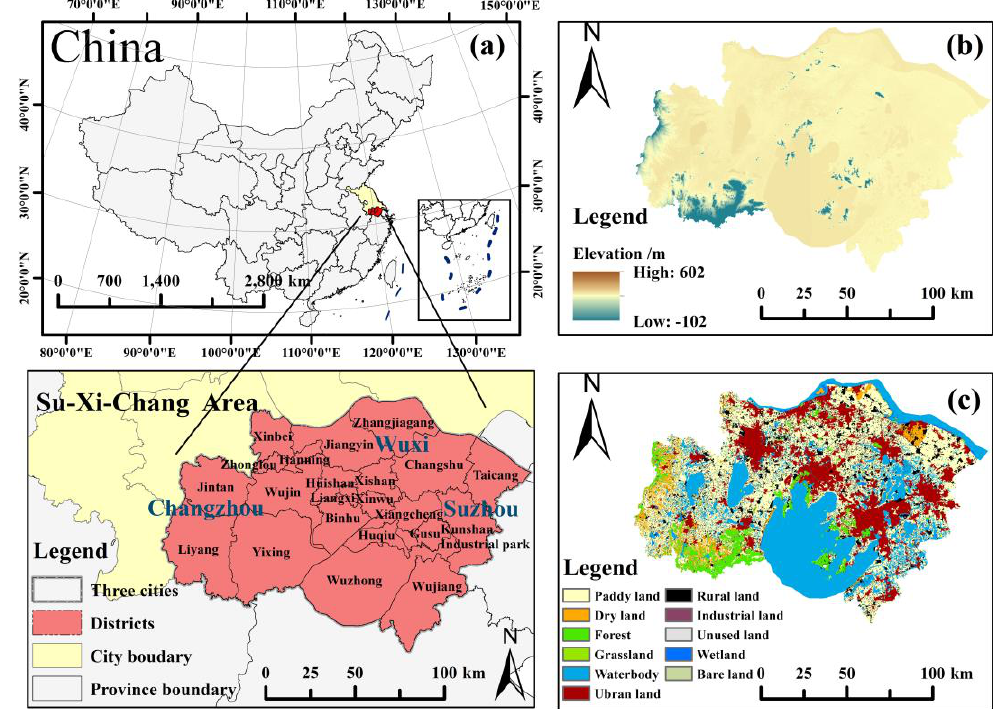
Figure 1. Map ( a ) shows the location Su-Xi-Chang area and maps ( b , c ) show its elevation as well as land use and land cover in 2018.